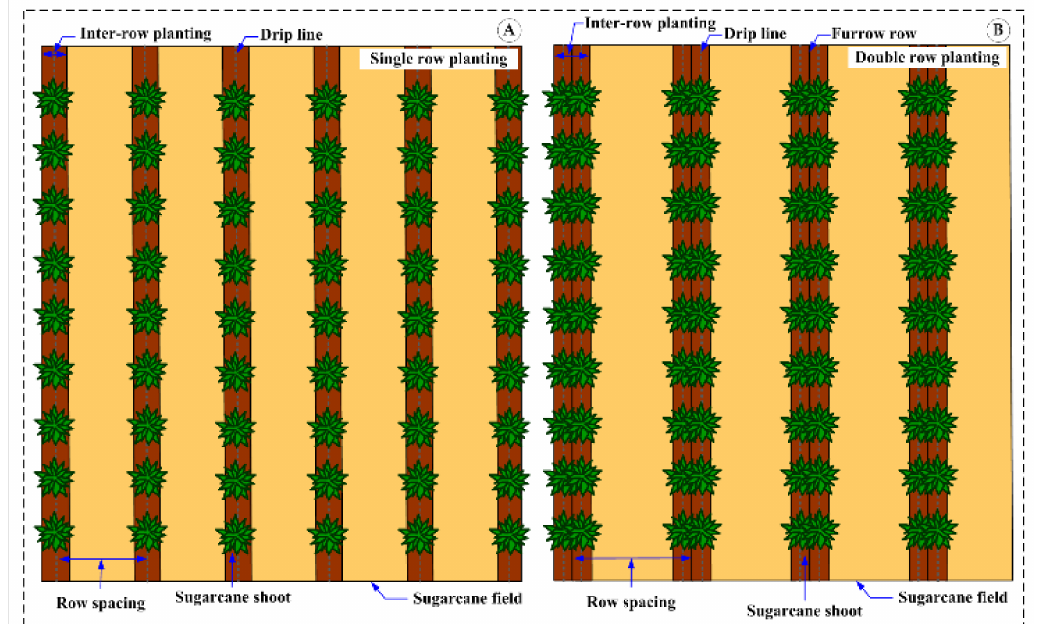
Figure 3. Characteristics of main sugarcane planting patterns: ( A ) single row planting; ( B ) double row planting (source: adapted from Wang et al. [83] and Sanches et al. [84]).